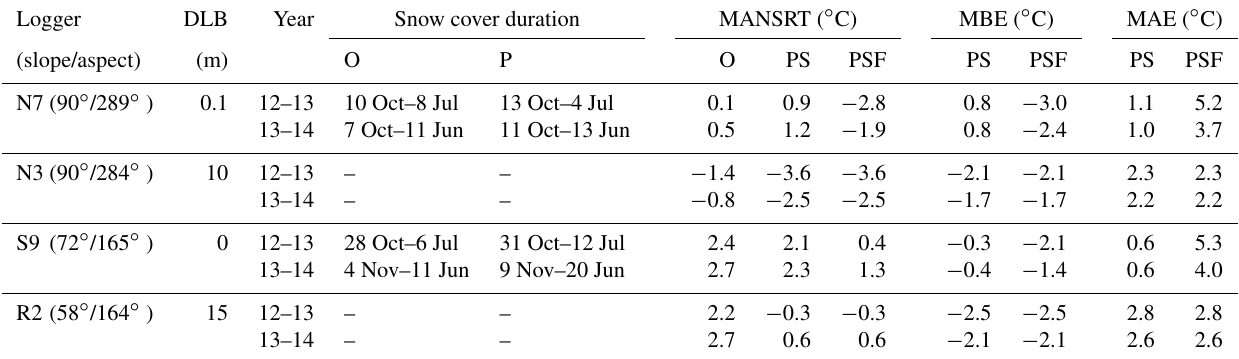
Table 1. Topographic characteristics of selected NSRT logger locations with different snow conditions and the distance to the nearest ledge below (DLB). In addition analysis of observed (O) and predicted (P) snow cover duration, as well as observed MANSRT and predicted MANSRT for both snow-covered (PS) and snow-free (PSF) scenarios at selected NSRT locations and for the years 2012–2013 (12–13) and 2013–2014 (13–14). The MBE and MAE were calculated between observations and model predictions of the snow-covered and snow-free scenarios.